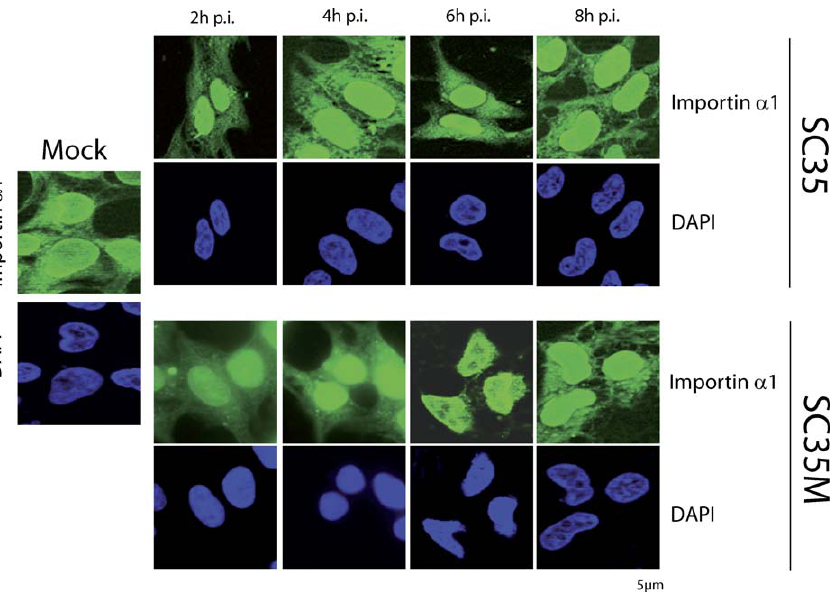
Figure 4. Kinetics of Nuclear Transport of Importin a 1 293T cells were infected at MOI 2 with SC35 and SC35M, and the localization of human importin a 1 was determined by immunofluorescence assays at different time points after infection (2 h p.i., 4 h p.i., 6 h p.i., and 8 h p.i.). For detection of importin a 1, FITC-coupled secondary antibody was used. Cell nuclei were stained with DAPI.